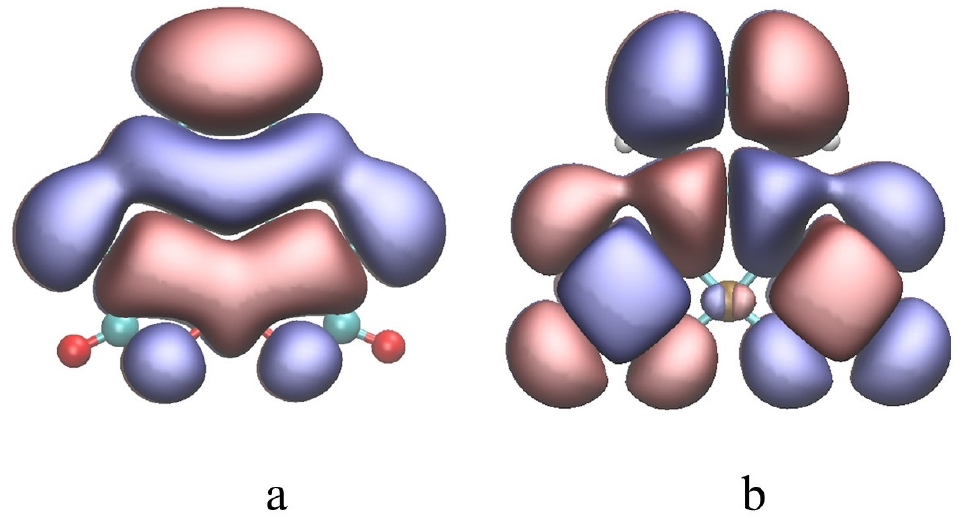
Figure 5. The ( a ) SOMO and ( b ) LUMO orbitals of [Cu(opba)] 2 − in ACN. The isodensity cutoff is 0.004 e/a 0 3 0.004 e/a 03 .